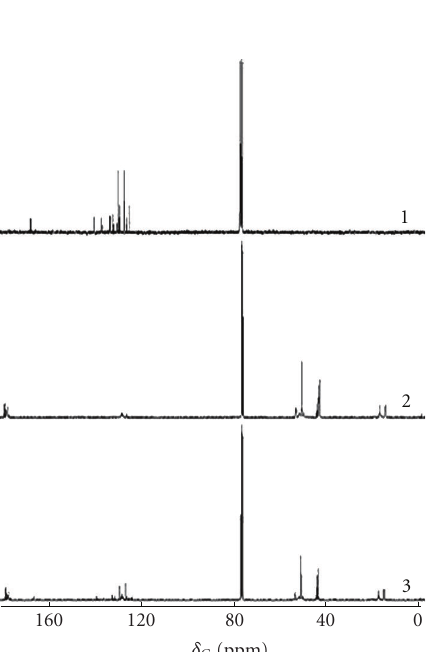
Figure 5: 13 C NMR spectra of Diimide (1), PMMA (2), and PMMA obtained in the presence 20 wt.% of Diimide (3).